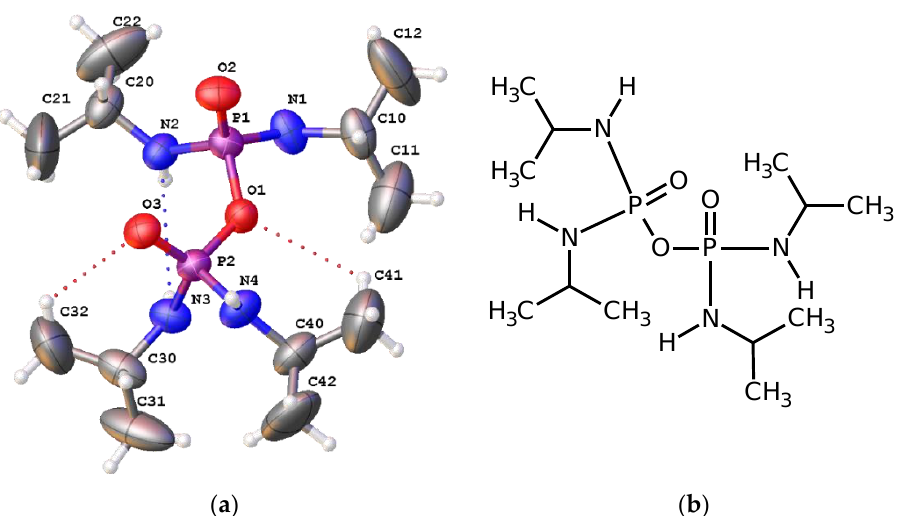
Figure 1. ( a ) Molecular structure obtained for O(( i PrNH) 2 PO) 2 the hydrogen bonding N3–H1 ··· N2 (blue) and the weak hydrogen bonding observed as C32–H32A ··· O3 and C41–H41A ··· O1 (red)(generated using Olex2 [23]); ( b ) molecular diagram for O(( i PrNH) 2 PO) 2 (generated using ChemSketch [24]).